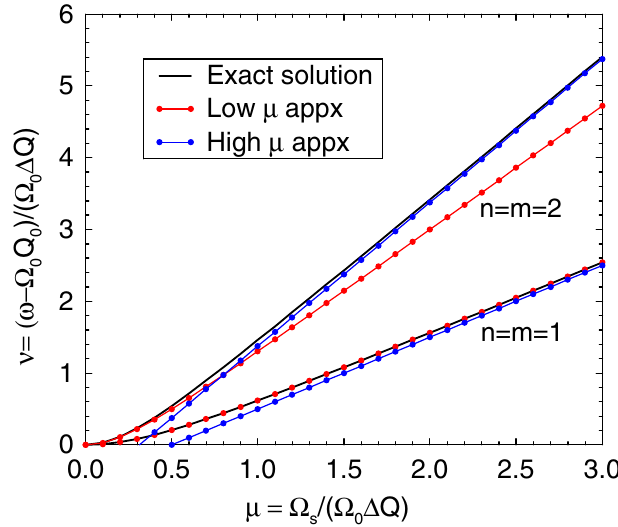
FIG. 14. (Color) Eigenvalues of the boxcar bunch. Low (cid:7) approximation perfectly coincides with an exact solution at n ¼ 1